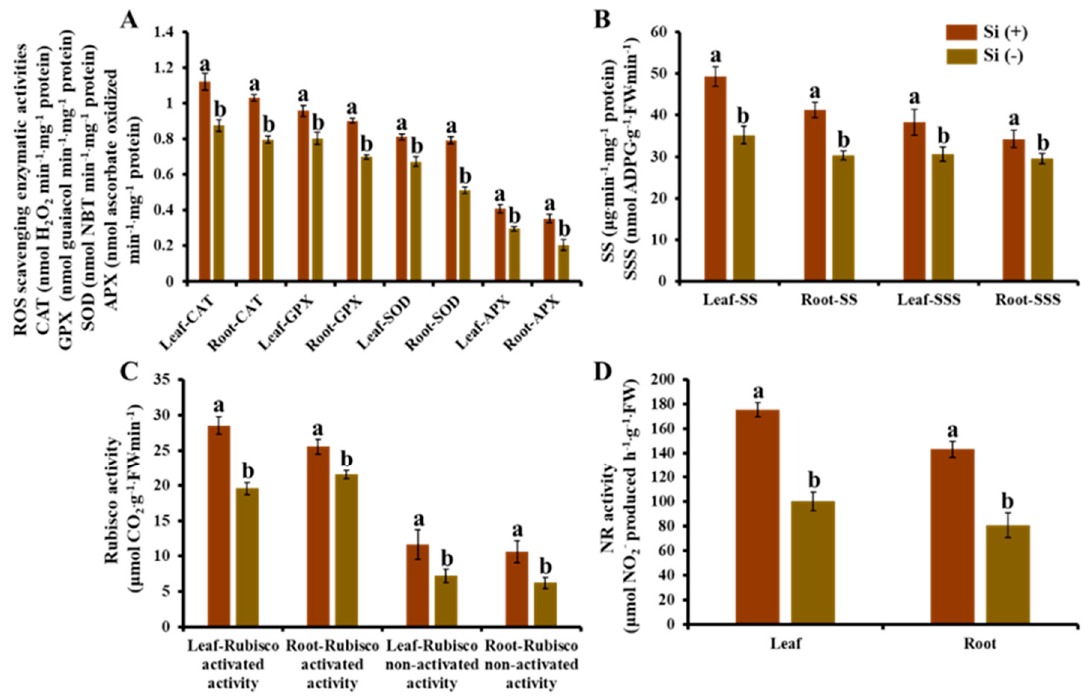
Figure 9. Effect of 30 days of silicon application on enzymatic activities in the coffee plants grown in plant growth chambers. The ROS scavenging enzymatic activities ( A ): Catalase (CAT), guaiacol peroxidase (GPX), superoxide peroxidase (SOD), and ascorbate peroxidase (APX). Carbohydrate synthesis related enzymatic activities ( B ): Sucrose synthase (SS), soluble starch synthase (SSS). Photosynthesis-related enzymatic activities ( C ): activated and non-activated activity of Rubisco. Nitrate reductase (NR) activity ( D ). Si (+) and Si ( − ) refer to 75 and 0 mg·L − 1 , respectively. Vertical bars indicate the means ± standard error ( n = 6). Different lowercase letters indicate the significant separation within treatments by the Duncan’s multiple range test at p ≤ 0.05.